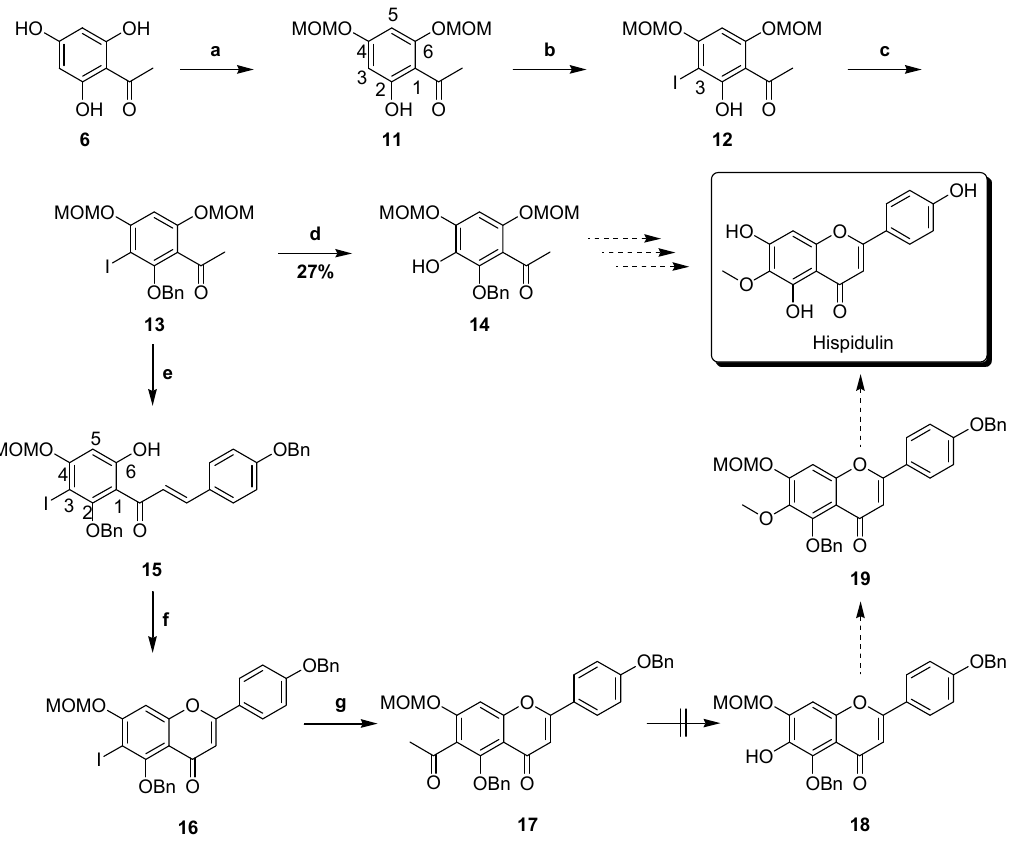
tributyl(1-ethoxyvinyl)tin was used to optimize Stille coupling. First, catalyst Pd(PPh 3 ) 4 was used in